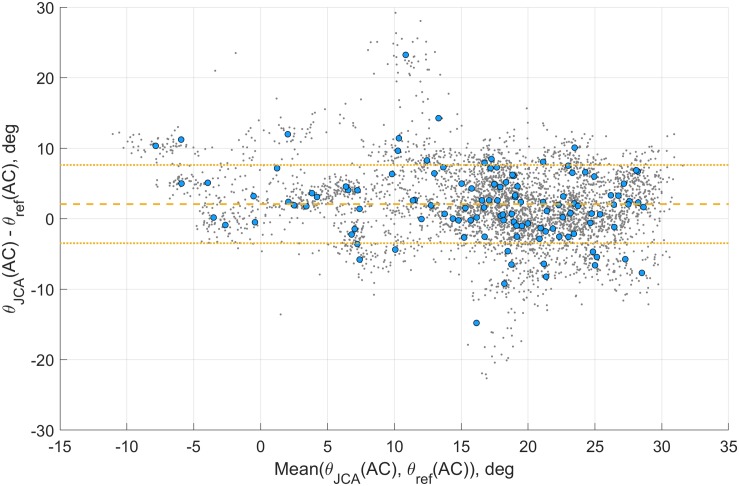
Bland–Altman plot of the activation pitch angle [θJCA(AC)] for the JCA method. The gray dots show the agreement of each step, the blue circles the agreement of the intra-trial mean, and the yellow lines the mean ± STD of the error.